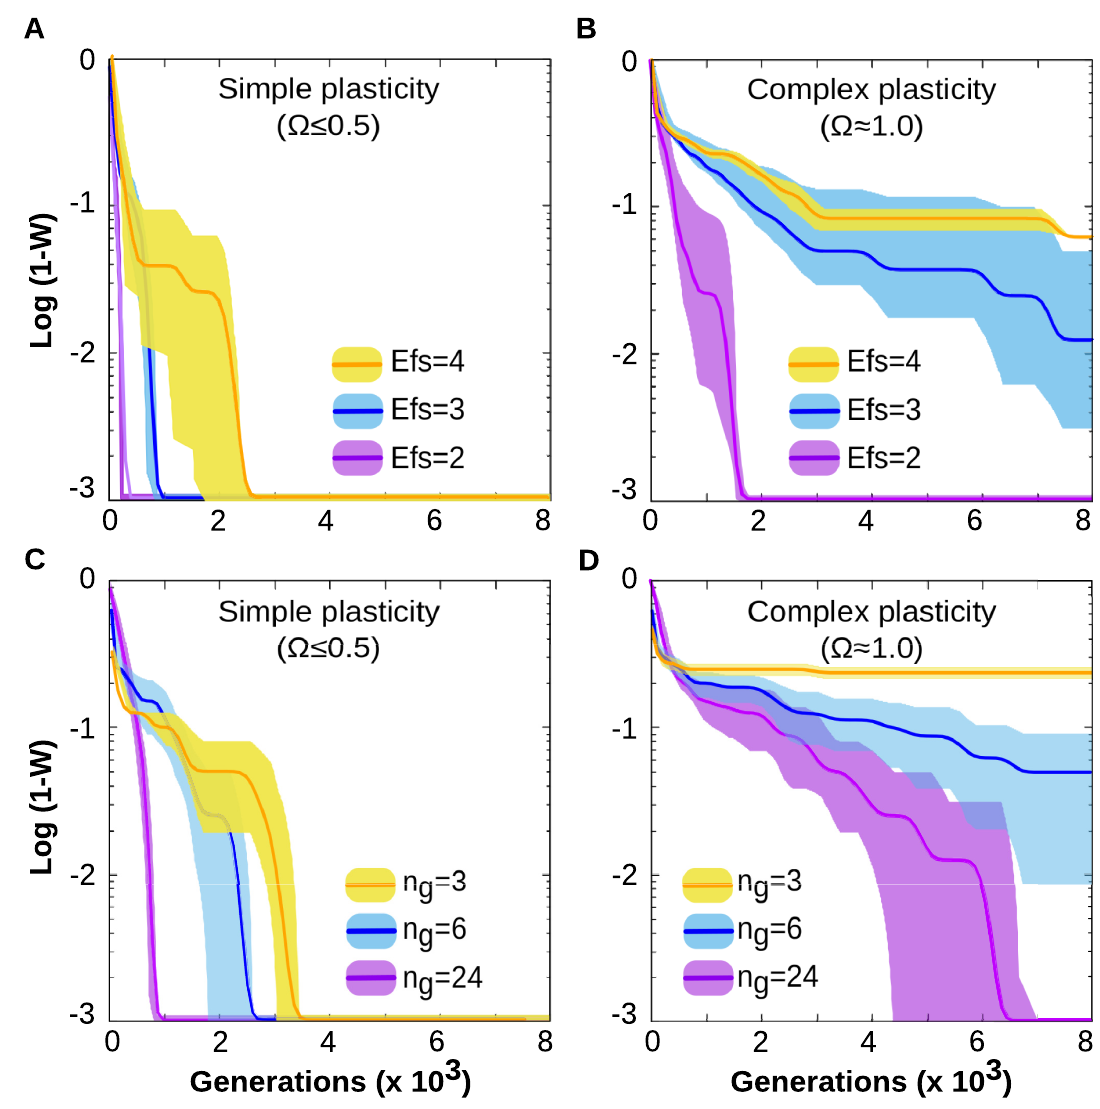
Fig 2. Plastic cells are able to evolve forms of plasticity of arbitrary complexity. (A and C) Left panels: Different environmental inputs can be easily integrated in a phenotypic response by means of a simple forms of cell plasticity (e.g. AND, NOT functions). Evolving cells can also evolve complex forms of complexity (e.g. XOR, XNOR functions), but they take longer to do this. In general, evolving a specific form of cell plasticity is faster when the number of environmental factors involved is low (Upper panels A-B), and/or when the size of the GRN is large (Lower panels C-D). Below certain thresholds in the number of environmental factors and in the GRN size, (which are complexity- dependent), the system fails to accurately represent the function (see yellow lines in the right panels). Each line shows the average and standard deviation over 30 replicates. Each replicate has the same initial conditions (an “empty network” with B ij = 0 , 8 i , j 2 [1, Ng ])but traces a different evolutionary trajectory (different mutations). For each replicate, the target function is randomly drawn from the set of possible functions with the same Ne and O . Ng = 12 in A-B and Ne = 3 in